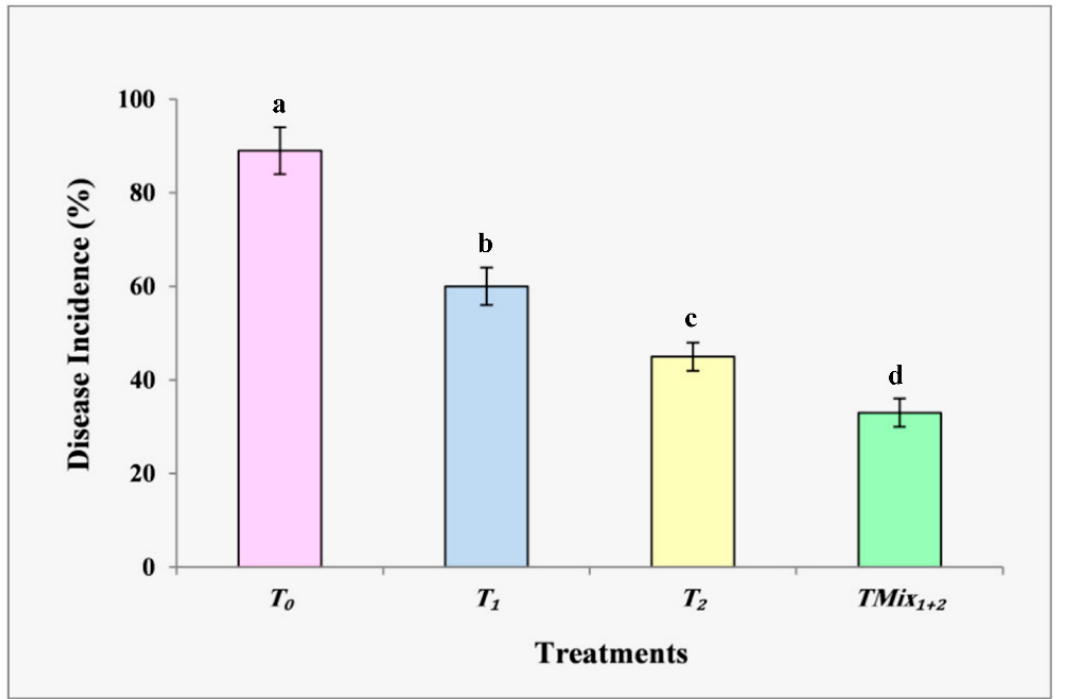
Figure 5. Disease incidence (%) at 45 DAT under greenhouse conditions after treating infected cherry tomato plants with different Trichoderma treatments, ( T 0 ), infected control with F. solani , ( T 1 ), T. viride , ( T 2 ) , T. harzianum , and ( TMix 1+2 ), a mixture of the two Trichoderma isolates. Error bars represent the standard deviation of the mean. Different letter(s) above the error bars indicate statistically significant differences at ( p ≤